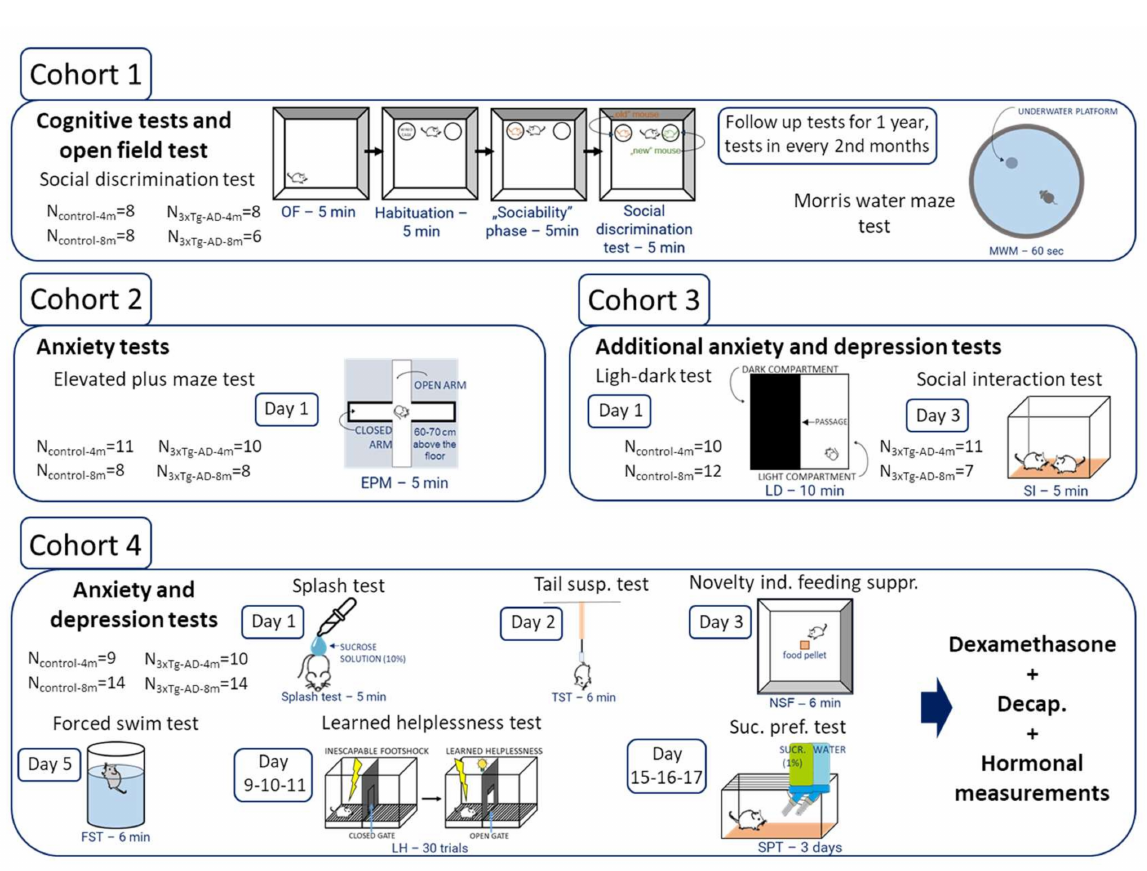
Figure 5. The experimental design in different